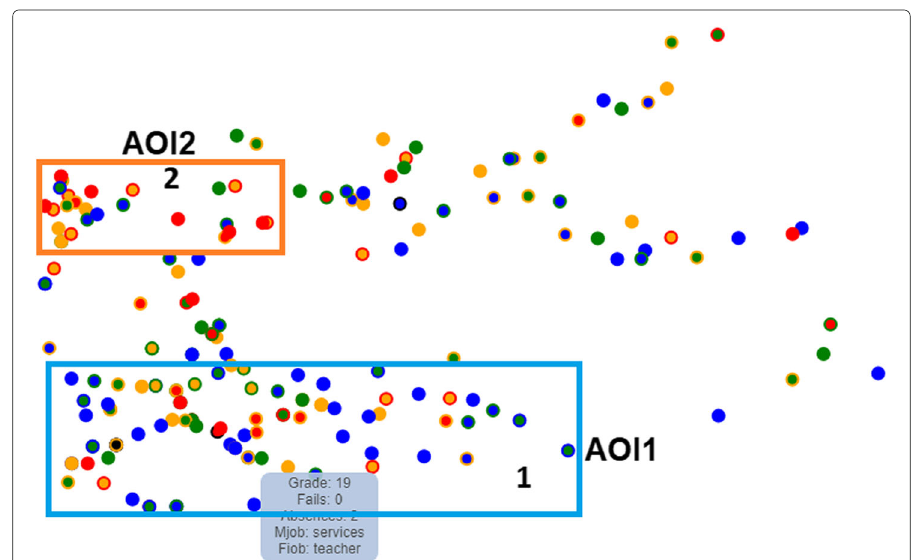
Fig. 20 Isomap for "Mathematics" class, period 1, considering male students